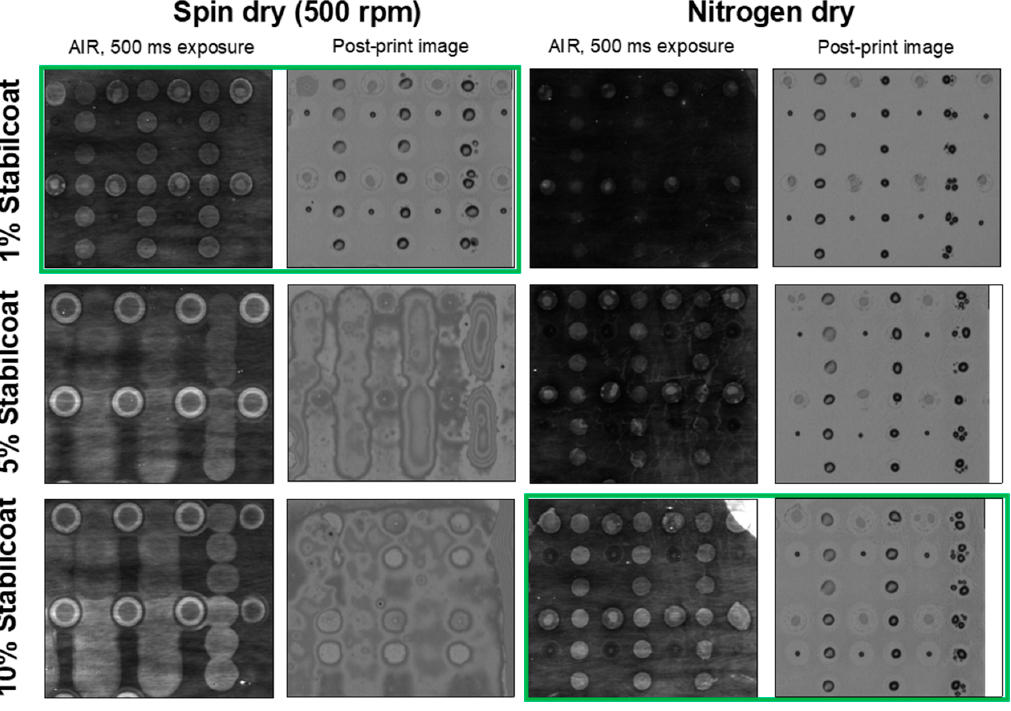
Figure 3. Optimization of protective coating conditions. The protective layer must be thin enough for probes to dissolve through cleanly during the printing process without substantial radial diffusion, but thick enough to prevent degradation of the biotin-SA surface. Printer head-cam and AIR images are shown for comparison. The spin-dry procedure requires a lower percentage of StabilCoat Plus ® in Nanopure TM (1% is optimal) than drying under a nitrogen stream (10% is optimal). Optimal conditions in each case are highlighted in green. Arrays consist of biotin anti-FITC flanking thrombin 29-mer (top 3 rows) and 15-mer (bottom 3 rows).